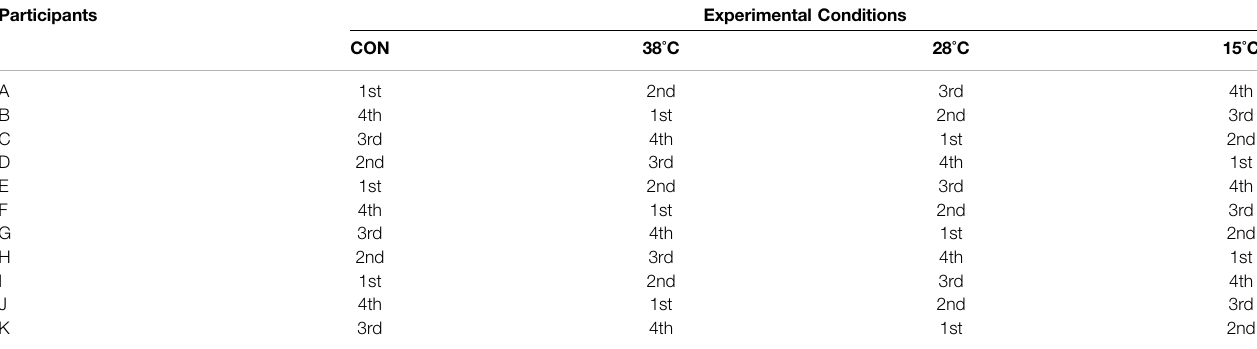
TABLE 1 | Cross-over design used in the